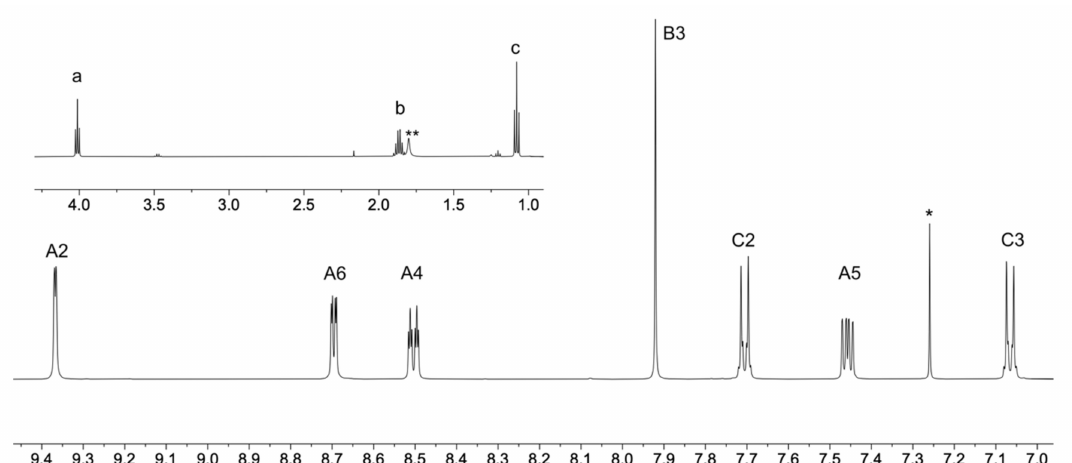
Figure 1. The aromatic region of the 1 H NMR spectrum (500 MHz, CDCl 3 , 298 K) of compound 3 with the alkyl region shown in the inset. Scale: δ / ppm. * = residual CHCl 3 . See Scheme 4 for atom labels.